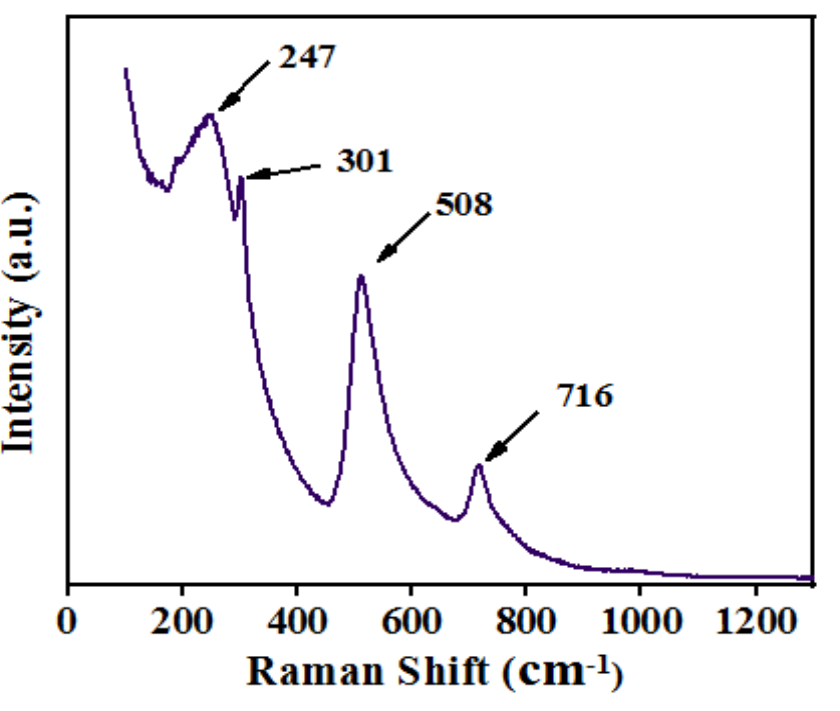
Figure 3. Raman spectrum of BST-BZT